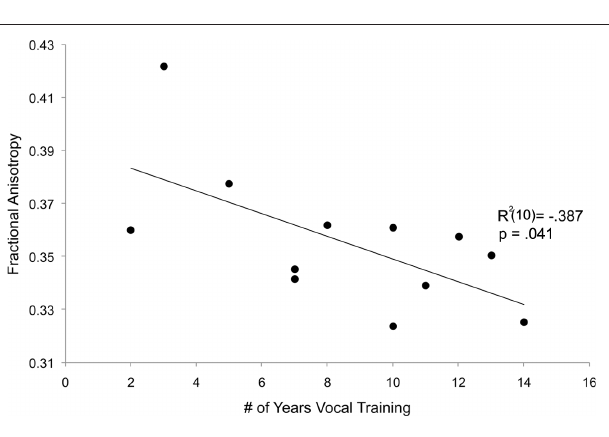
Figure 8 | Numbers of years of vocal training (singers’ group only) inversely predicts mean FA value of the left dorsal